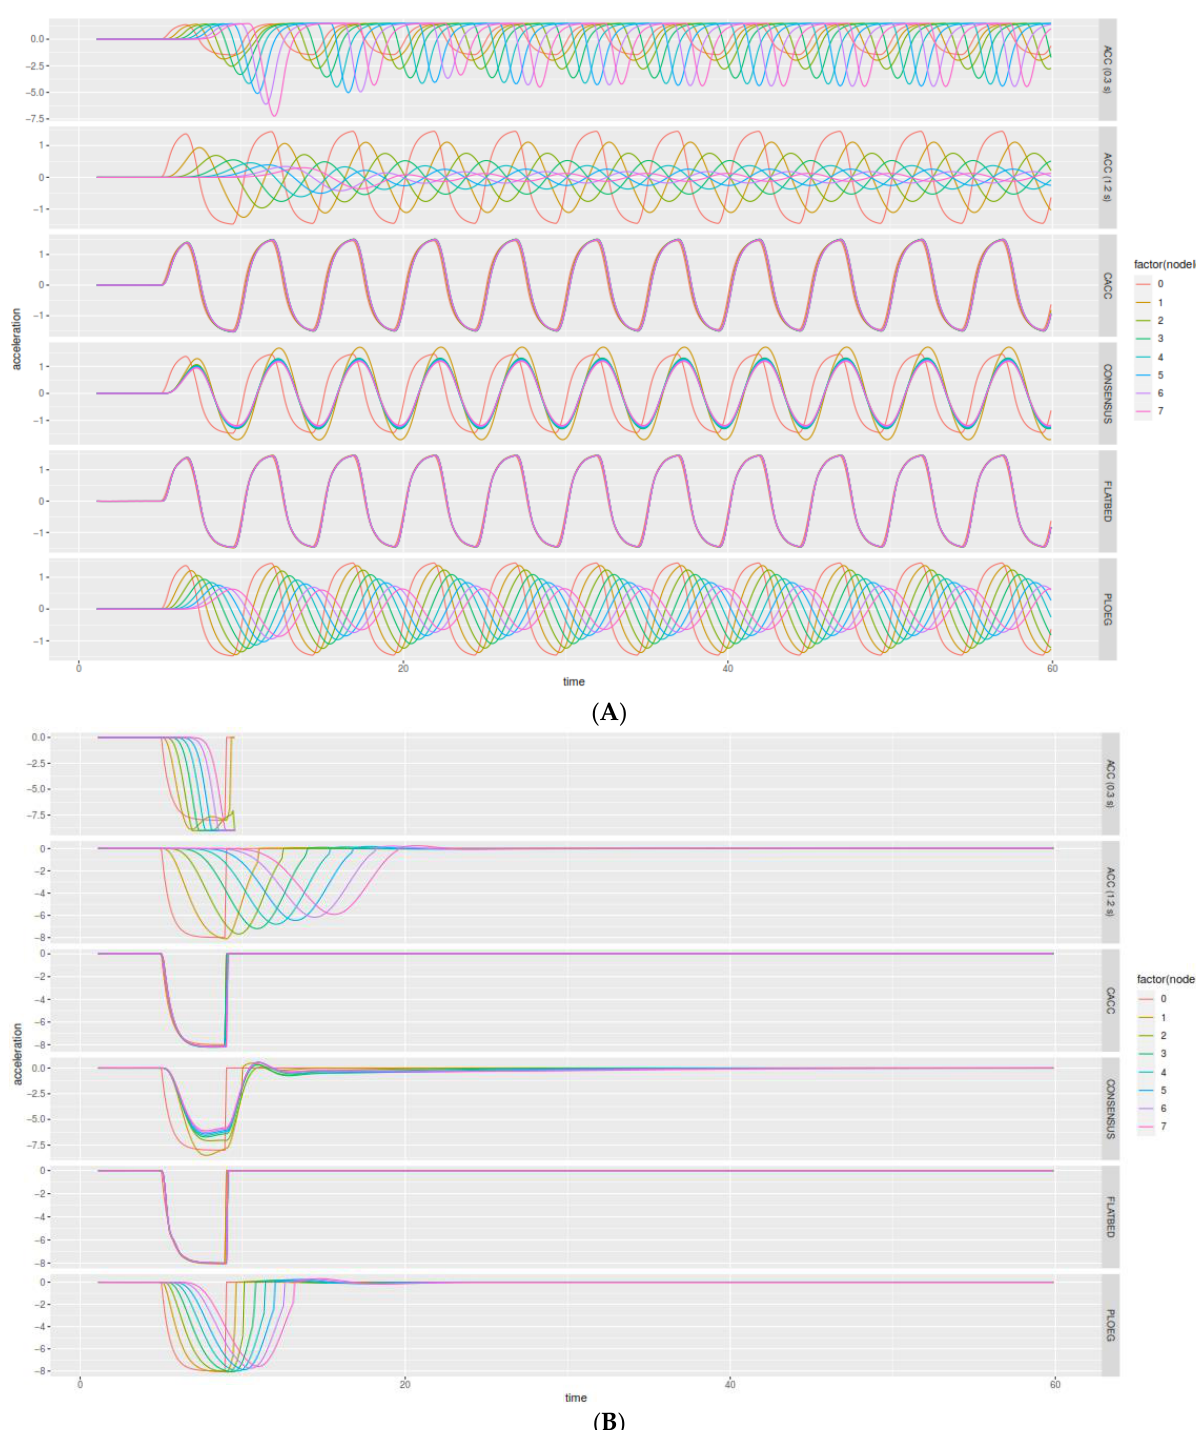
Figure 7. ( A ) ACC controllers Analysis. ( B ) Sinusoidal acceleration analysis.